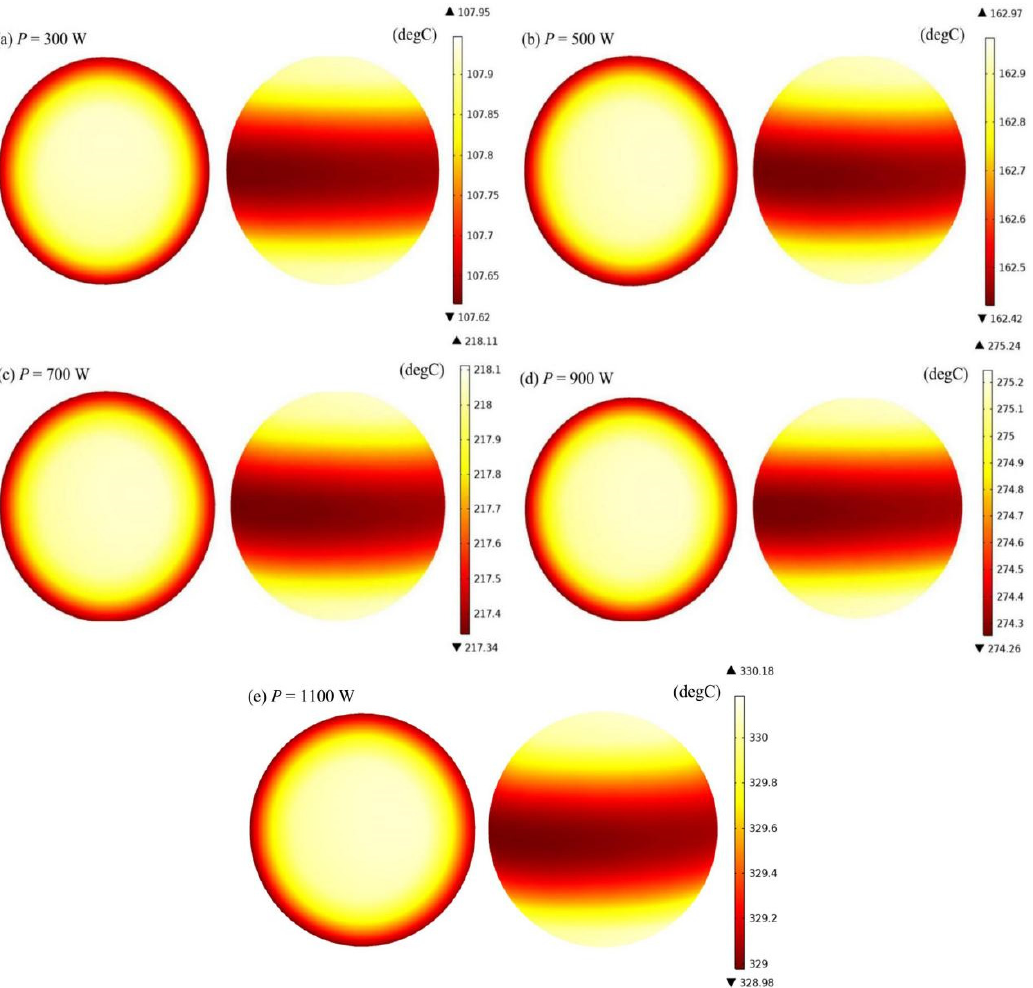
Figure 7. Temperature distribution of the oolitic particle model under different microwave powers, with a microwave heating time of 120 s: ( a ) 300 W, ( b ) 500 W, ( c ) 700 W, ( d ) 900 W, ( e ) 1100 W.